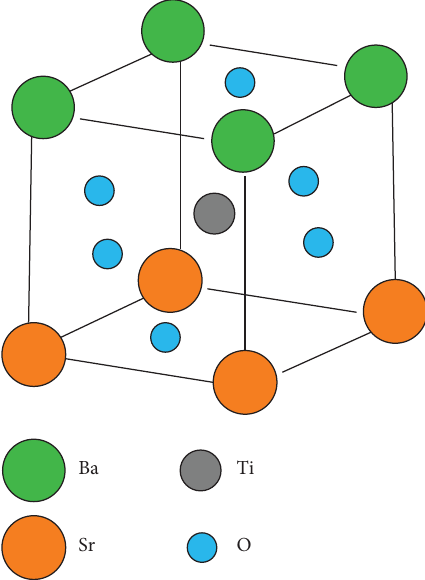
Figure 3: Nonpolar structure of BST at the room